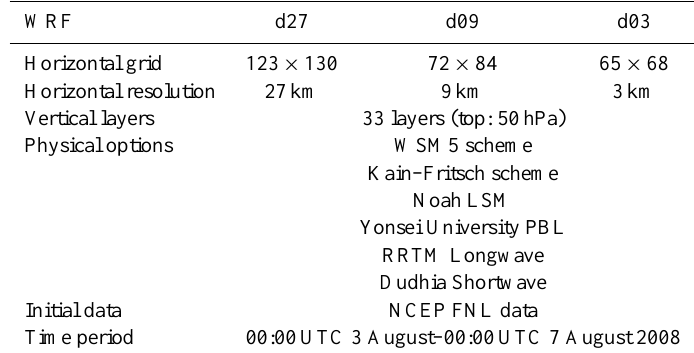
Table 1. Configuration of WRF modeling system.